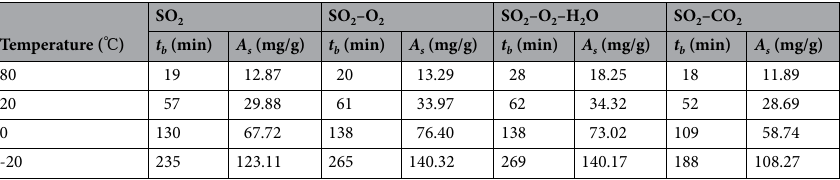
Table 6. Adsorption characteristics of SO 2 over activated carbon (SO 2 = 1000 ppmv, O 2 = 6 vol.%, CO